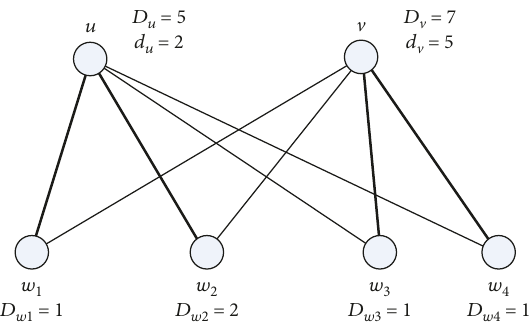
Figure 7: Example for measuring interference